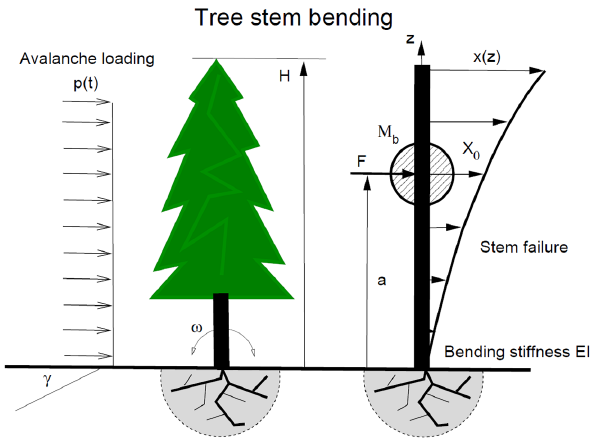
Figure 3. A tree of height H breaks by overturning at the root-plate. The avalanche exerts a loading p(t) of known (but short) duration. The load acts in the centre-of-mass of the tree located a distance a from the ground. The mass of the linear distributed mass of the tree stem is m t and the lumped mass of the branches is M b . Tree defor- mation is given by the linear distribution v(z)